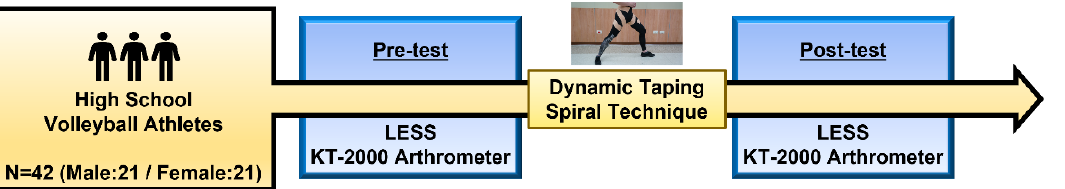
Figure 1. Experiment flowchart. Forty-two participants completed LESS and knee laxity examina- tions with a KT2000 arthrometer and then received dynamic taping. After taping, measurements of LESS and knee laxity were repeated immediately.